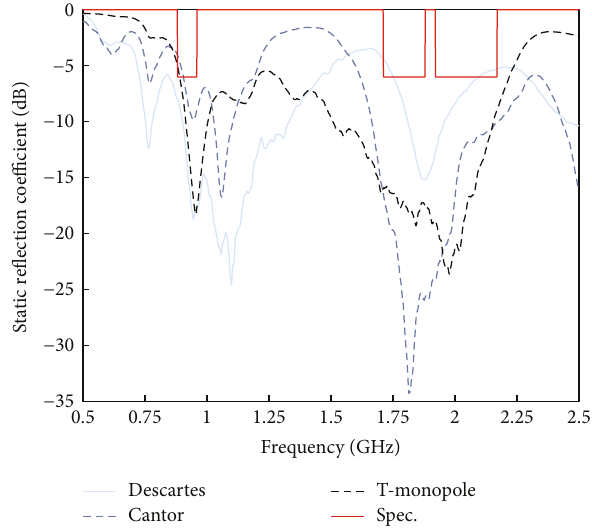
Figure 3: Static re fl ection coe ffi cient of the antenna FDD LTE B3 bands [19] are tested in the up- and down- link operative frequencies: